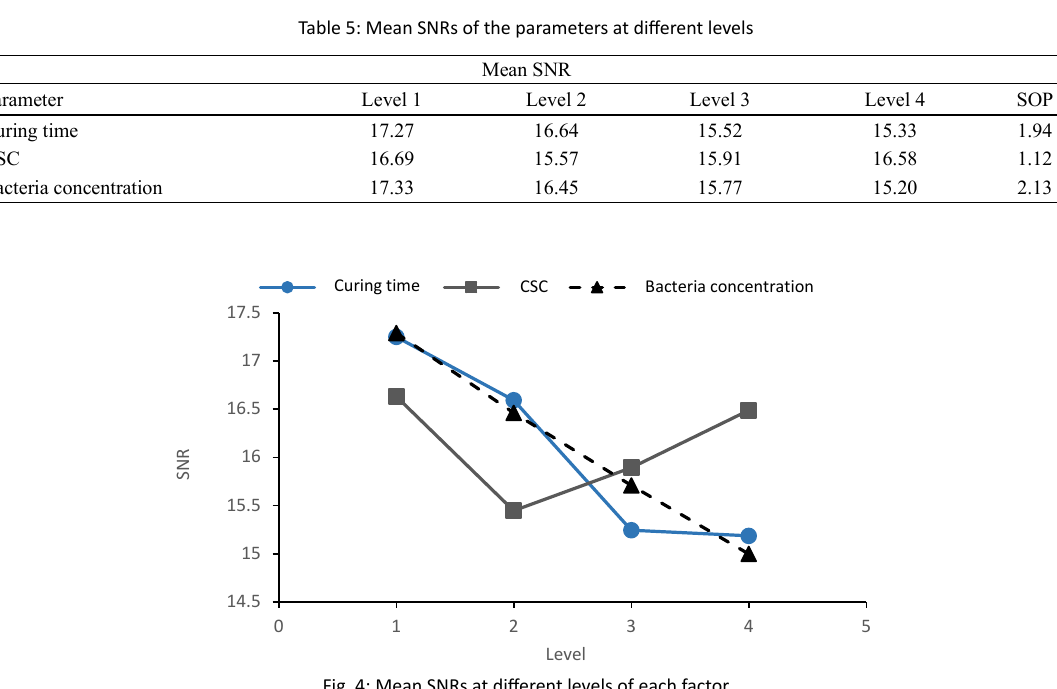
Fig. 4: Mean SNRs at different levels of each factor